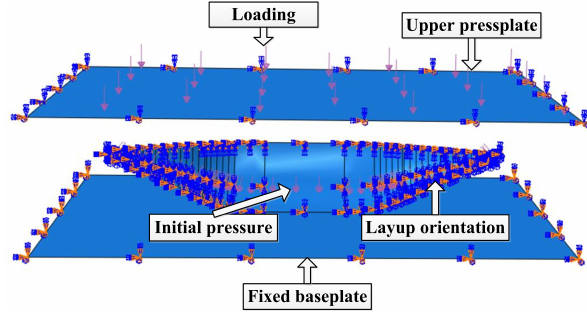
Figure 10: Components and boundary